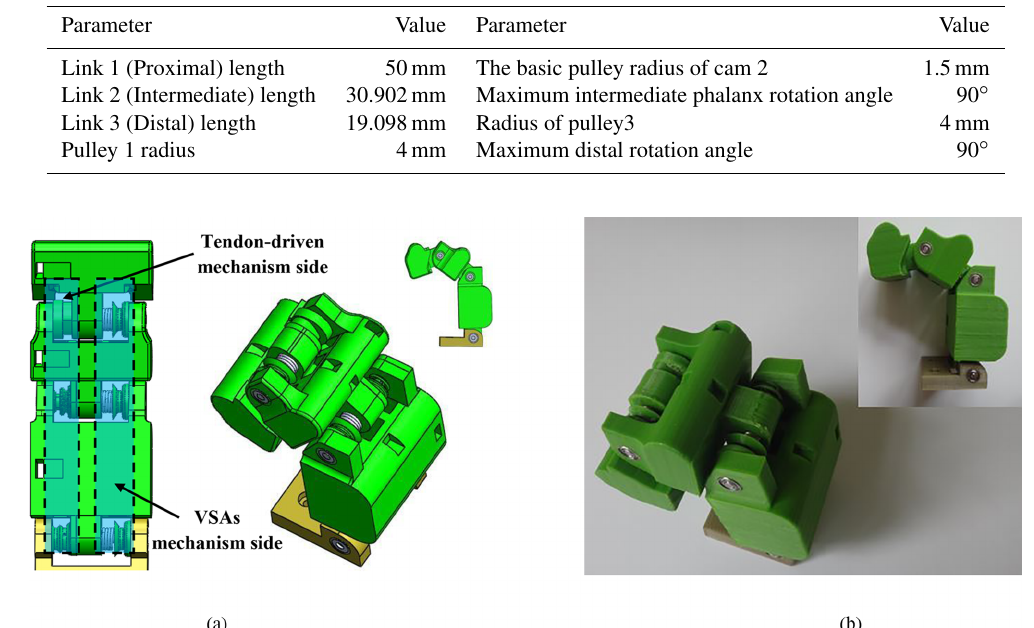
Table 3. Parameters of design cam 2 and cam 4.